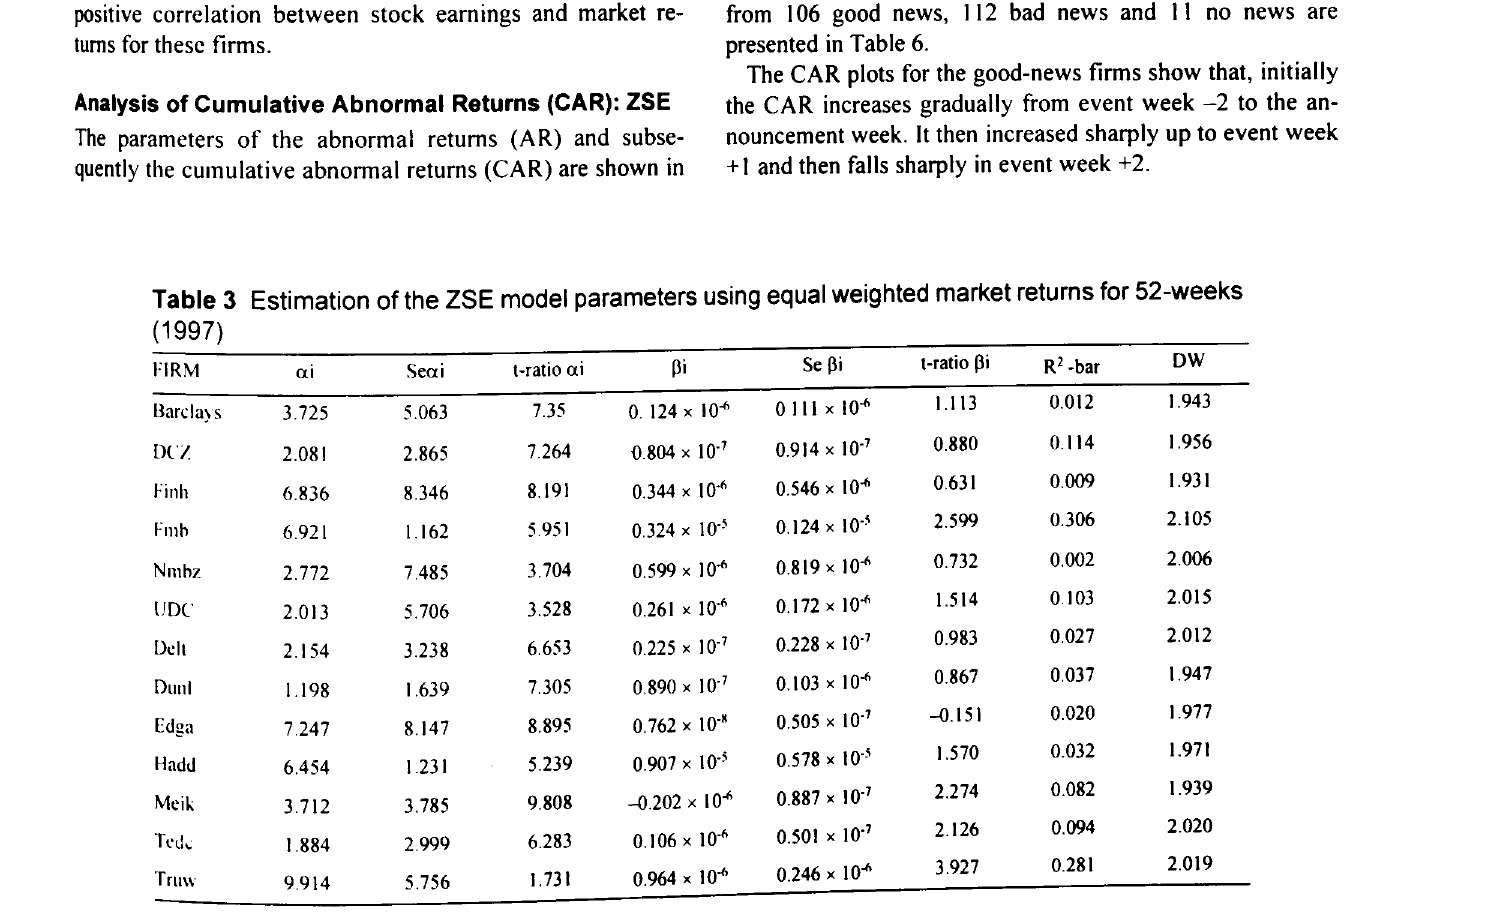
Stock pricing characteristics of the ZSE